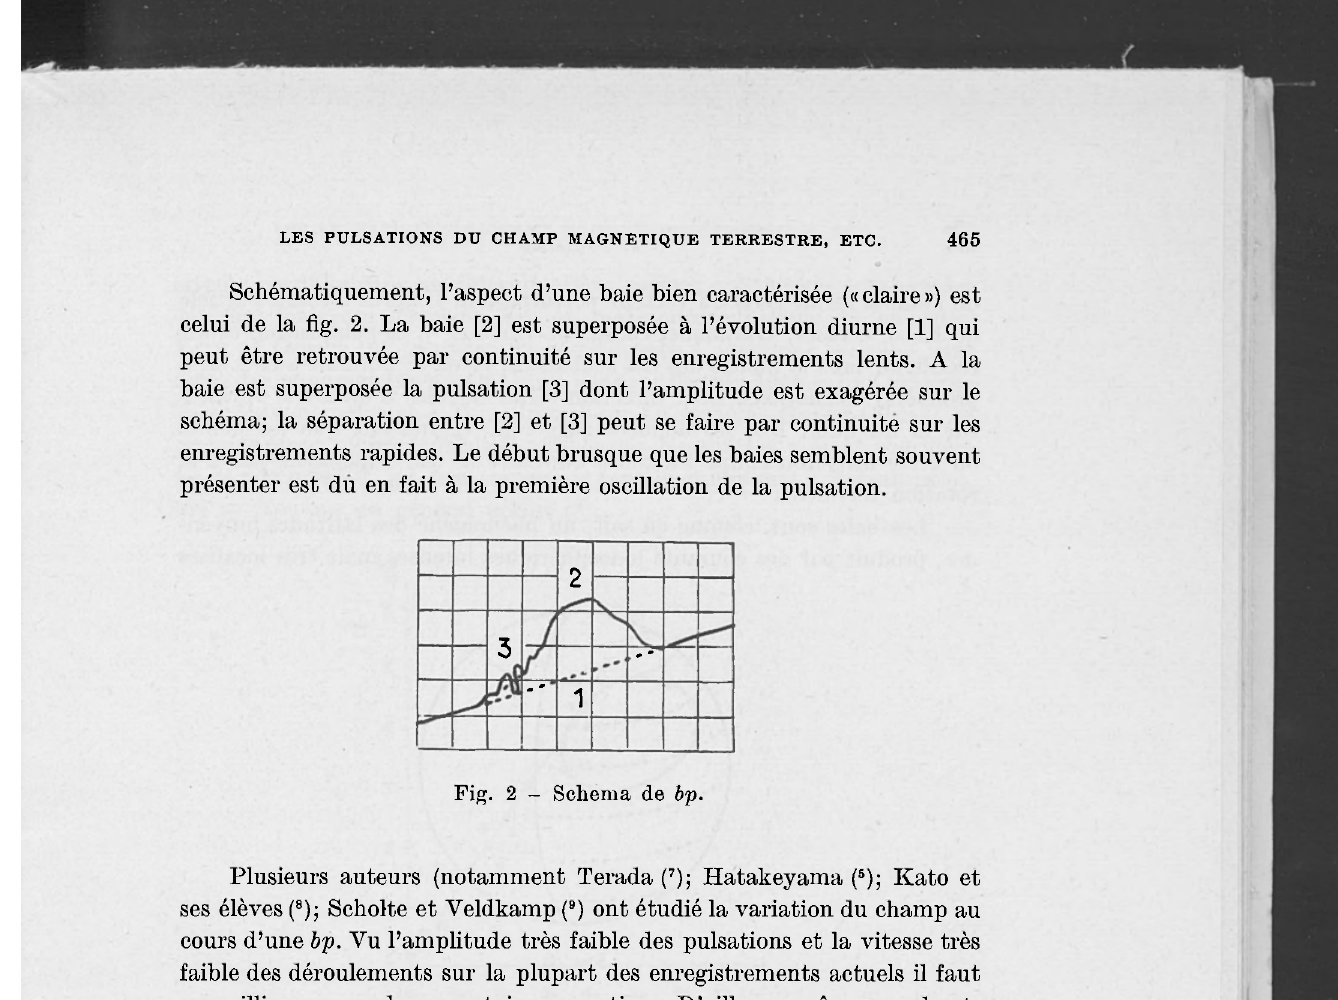
Fig. 2 - Schema de